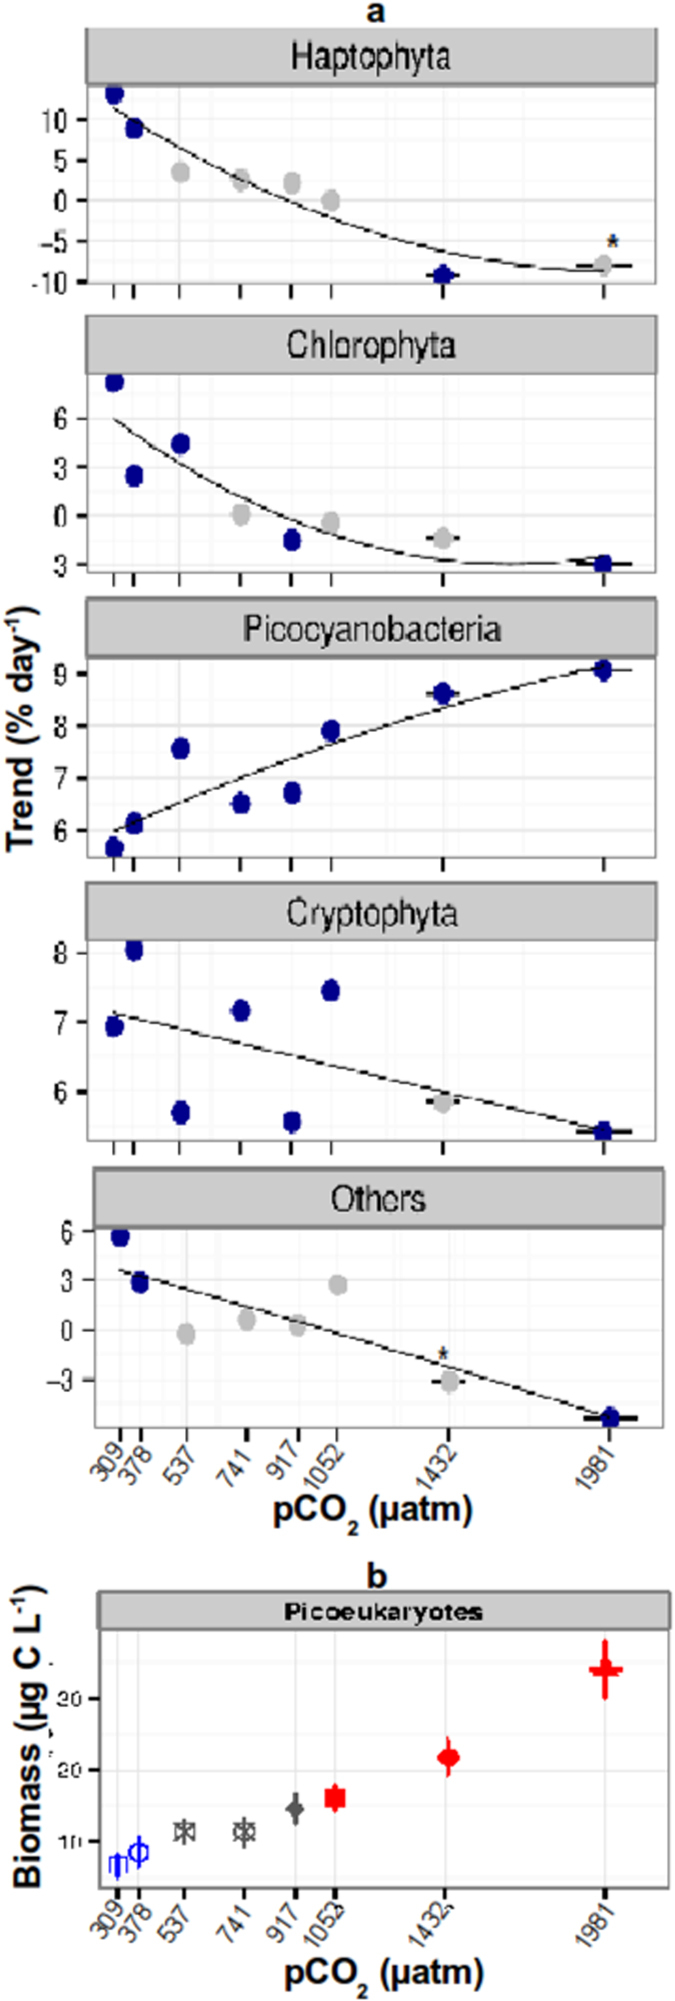
(a) Mann Kendall trend statistics of major phytoplankton taxonomic group biomass, between sampling days 3 and 25, across mesocosm treatments. Trends are shown as percent change per day (Trend %day-1); blue dots indicate significant trends (p < 0.05), grey dots no significant change (*p-value = 0.056). The x-axes display the mean pCO2 levels (μatm) during the analyzed time period in each mesocosm. (b) Mean of picoeukaryote biomass between day 3 and 25 during the experiment. A Mixed Effect Model analysis revealed a significant increase at elevated pCO2 levels in the biomass between the different treatments (pCO2: F = 83.2834, p < 0.0001, df = 84; time: p = 0.360; pCO2: time interaction, p = 0.102). Man Kendall trend test could not be applied to this group, as biomass increased non-monotonic during the experiment. Bars show standard error.